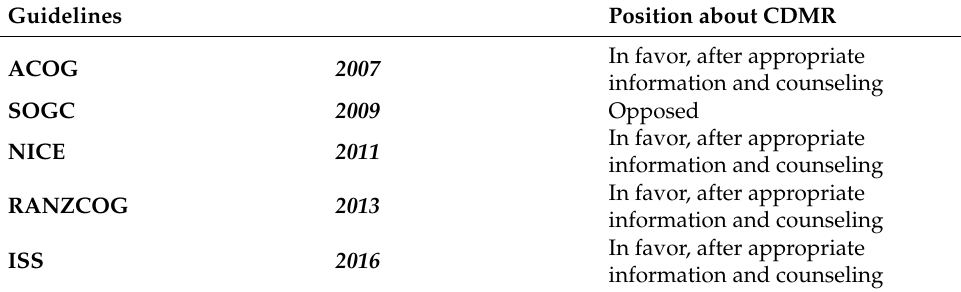
Table 1. International guidelines and